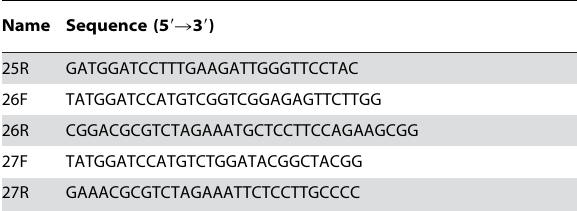
Table 4. Primers used in this study. Table 4.